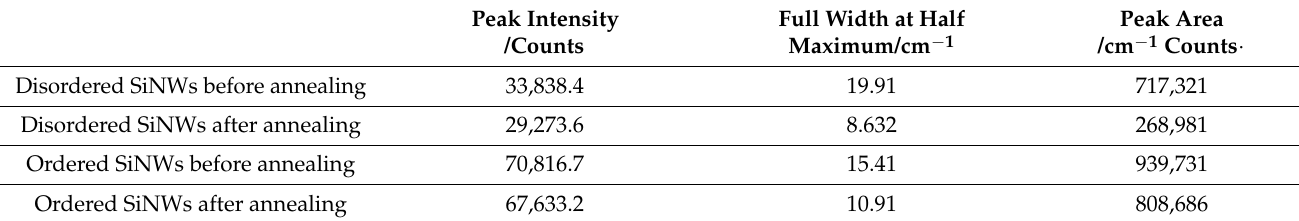
Table 1. TO peak information of four samples after